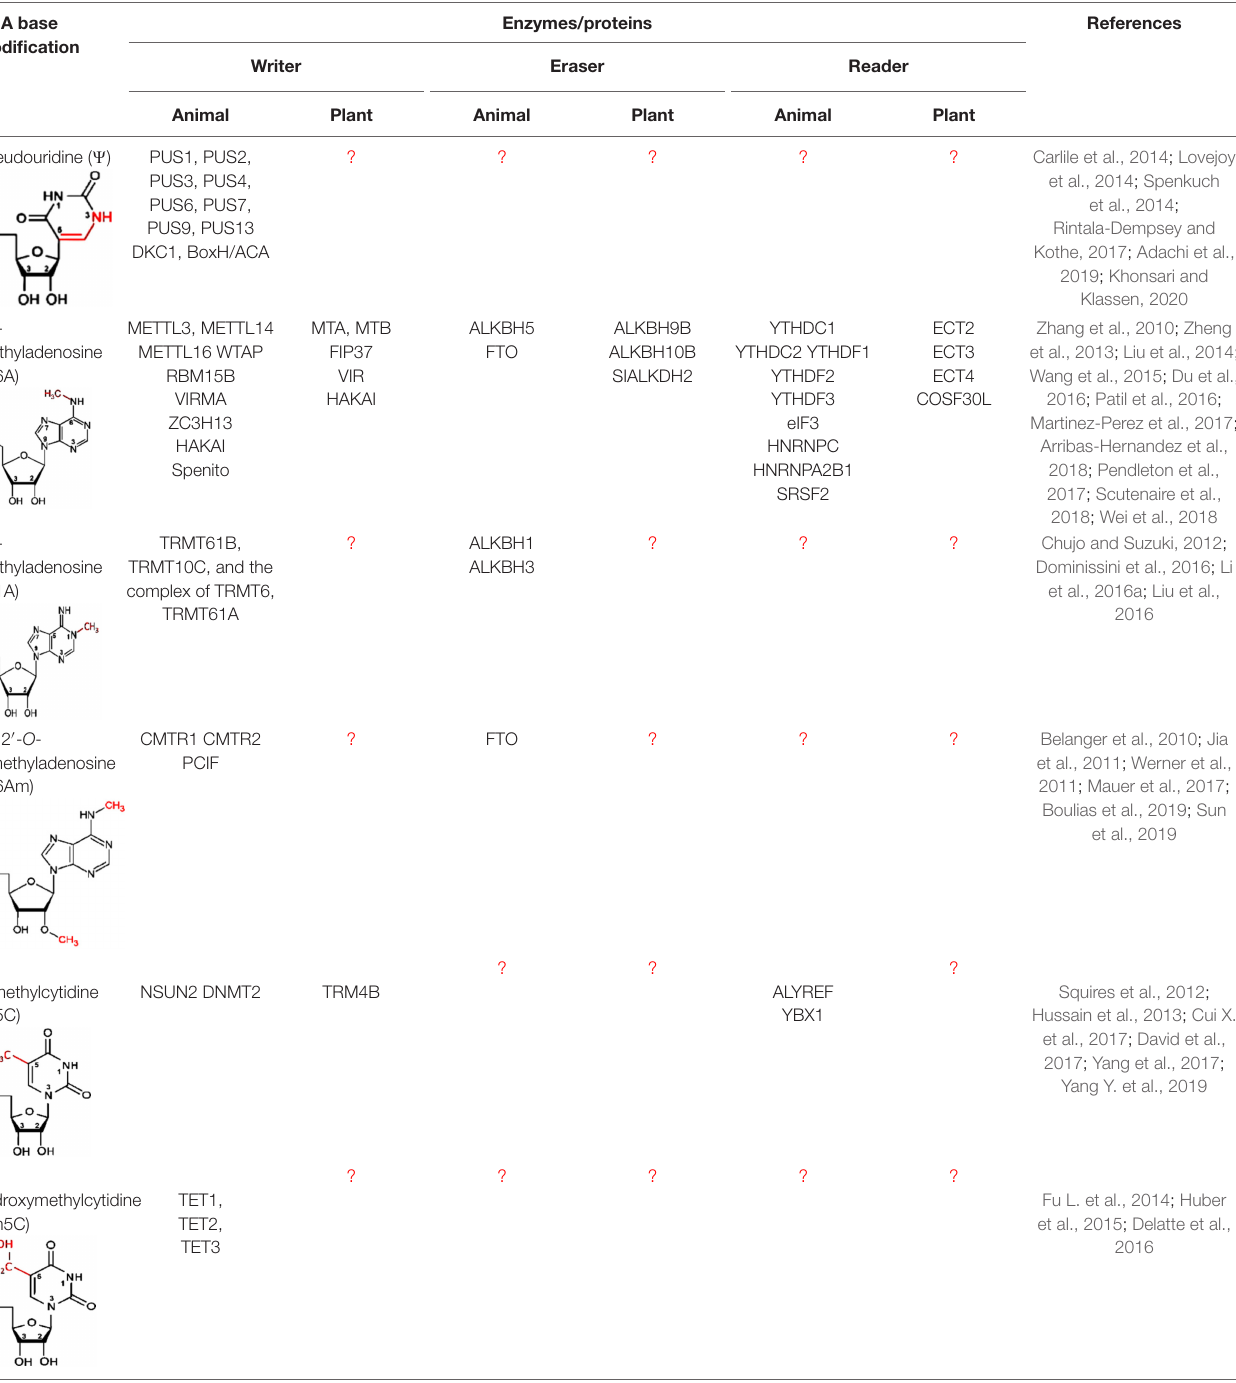
TABLE 1 | Modified RNA bases, their modulators, and